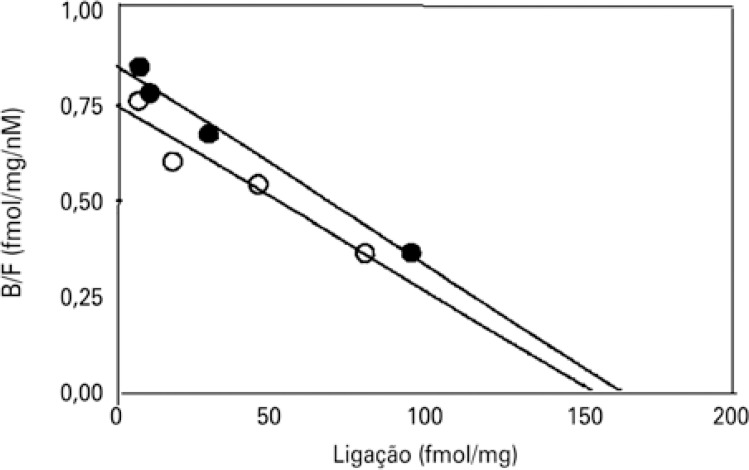
A análise de Scatchard de sítios de ligação específica do [3H]-NMS em homogenatos de bexiga de ratos controle (O, n=3) e diabéticos (●, n=3)